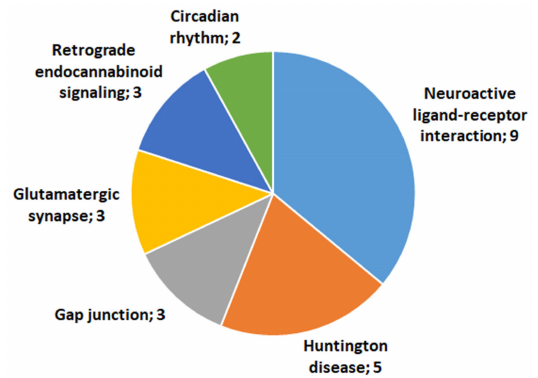
Figure 4. KEGG pathways related to the 31 genes associated with neurogenesis and found to be differentially expressed in our comparison of the hippocampal transcription profile between control male mice and males with consecutive 20 days of wins in daily agonistic interactions and then deprived of fighting for 14 days.